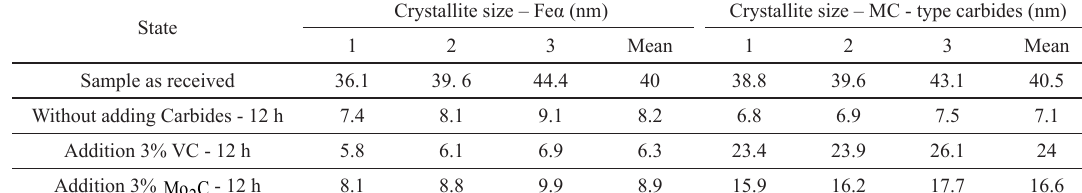
C after 12 hours of milling. 2